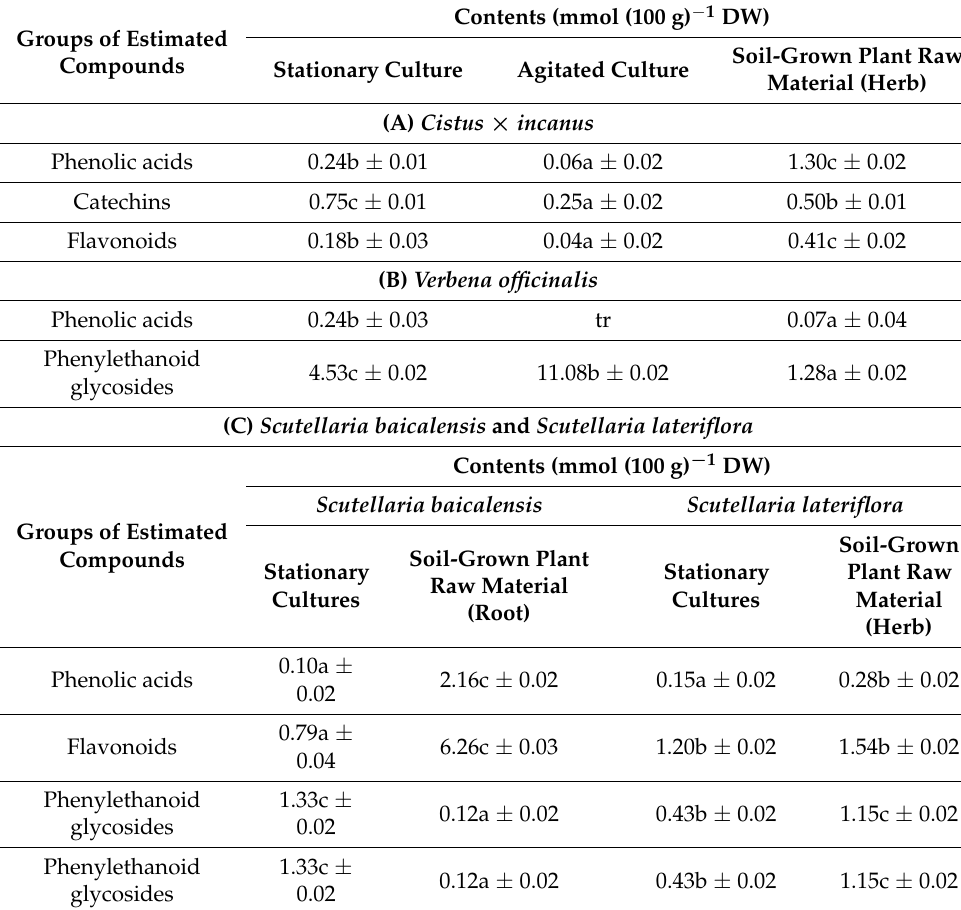
Table 2. Contents of different subgroups of polyphenolic compounds detected earlier by us (mmol (100 g) − 1 DW) in biomasses cultured in vitro and in soil-grown plant raw materials of Cistus × incanus acc. [15] (A) , Verbena officinalis acc. [17] (B) , and Scutellaria baicalensis and Scutellaria lateriflora acc. [22] (C) . Mean values ± SE, the same superscript letter means lack of statistical significance between treatments (n = 5, p < 0.05), tr: